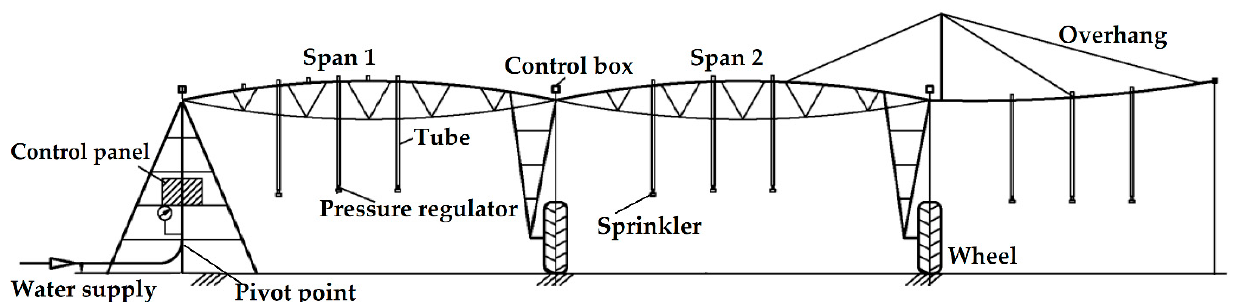
Figure 4. Schematic of the center pivot irrigation system.